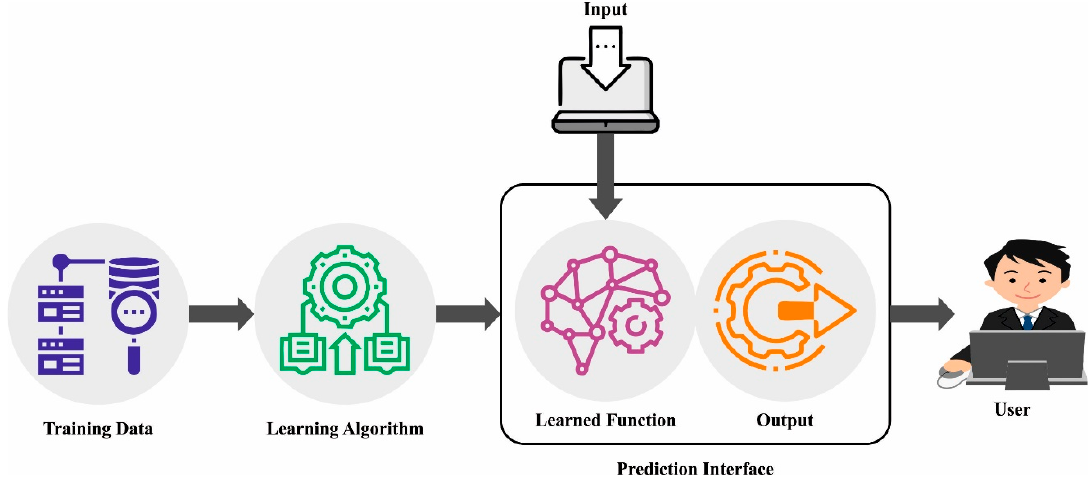
Figure 1. Structure of XAI.